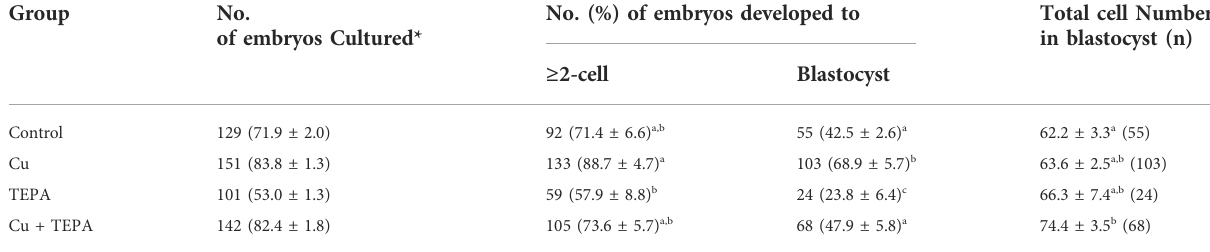
*: Three times replicated. n: The number of blastocysts